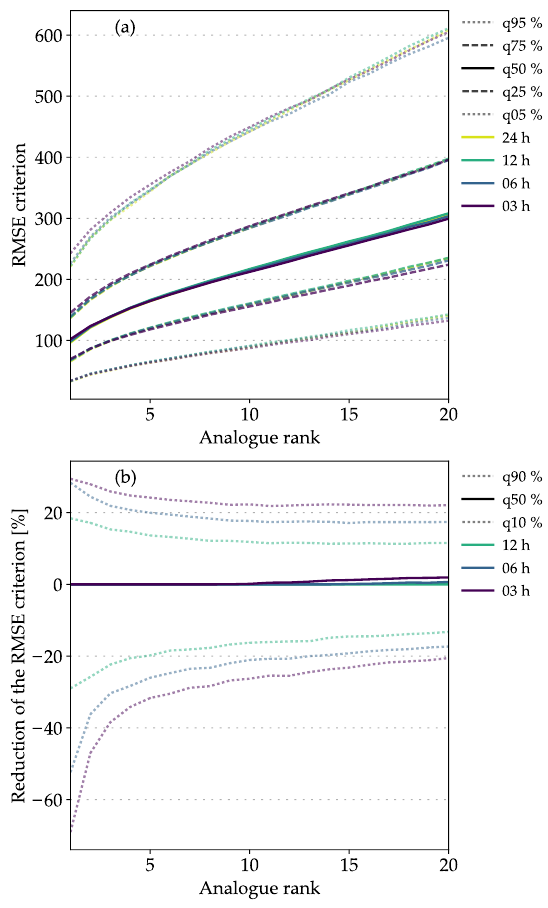
Figure 8. Synthesis of the changes in the RMSE criterion due to the MTW for the Ulrichen station, depending on the rank of the analogue. (a) Quantiles of the RMSE distributions with and without the MTW. (b) Quantiles of the relative improvements of the RMSE criterion when using the MTW.